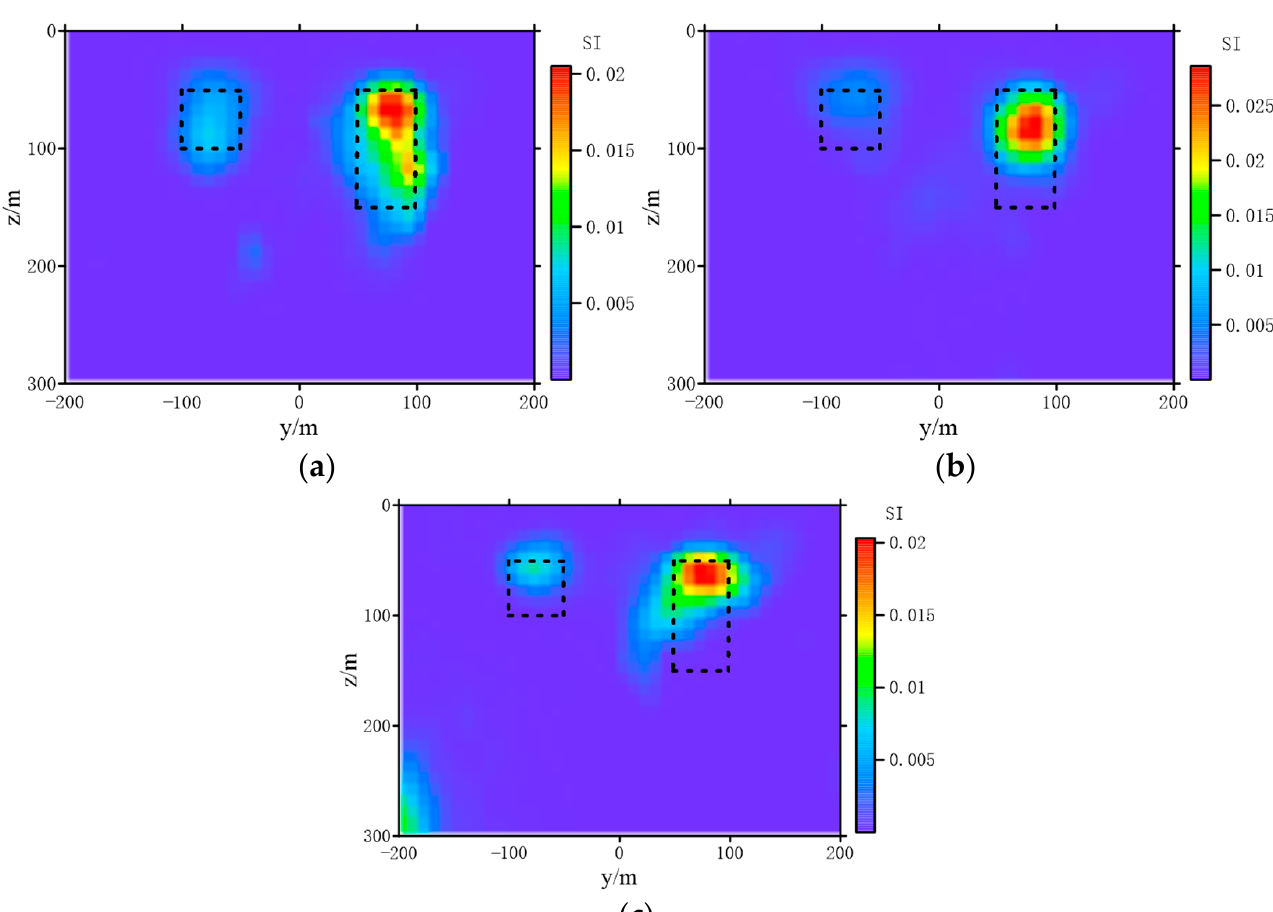
Figure 11. The abnormal magnetic data of Model 3 with different noise level.